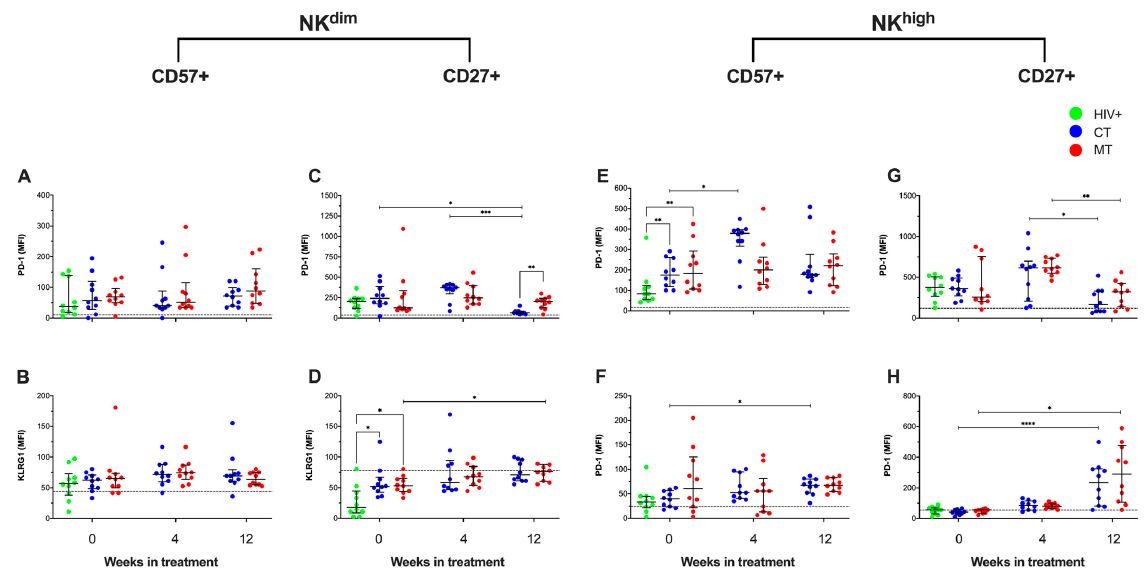
Figure 9. PD-1 expression was affected, while KLRG1 expression increased on CD27+ NKT dim cells . PD-1 and KLRG1 expression (MFI) on CD57+ and CD27+ cells of NKT dim ( A , B , E , F ) and NKT high ( C , D , G , H ) cell subsets were evaluated across the follow-up weeks in each group. The black dashed line represents the median value of HIV-negative men, green dots represent HIV+ asymptomatic men. Green dots represent HIV+ asymptomatic men; blue dots represent CT and red MT participants. Data are represented as median values and IQR. Statistical comparisons were performed using Kruskal–Wallis test, * p < 0.05, ** p < 0.01, *** p < 0.001, **** p <